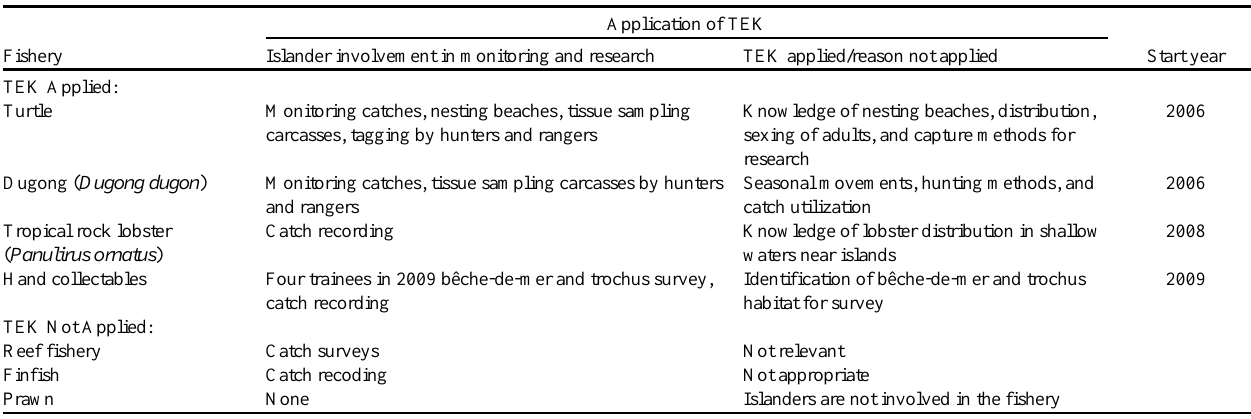
Table 2 . Fisheries for which traditional ecological knowledge (TEK) has and has not been applied in the Torres Strait, and the details of TEK